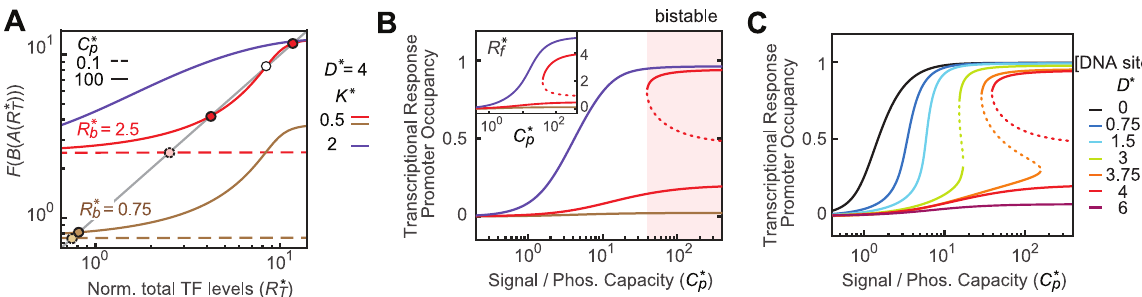
Fig 7. Steady-state responses of the autoregulated system. (A) Determination of steady states. Solid and dashed lines represent values of the RR production function F ( B ( A ( R T � ))). Intersections with the RR dilution curve (gray diagonal line) indicate the stable (solid circles) or unstable (open circle) steady states. Varying Cp � values gives steady-state solutions to calculate signal-dependent responses. (B and C) Mono-/bistable responses affected by R b � , K � (B) and D � (C). Occupancy of the promoter with an affinity K � rep = 1 is used to represent transcriptional responses. The inset in (B) shows steady-state R f � levels. Relevant parameters are: D � = 4, K � = 0.5, and R b � = 2.5. All curves shown in this figure are modeled with f = 5. Stable and unstable steady states are shown as solid and dotted lines, respectively.